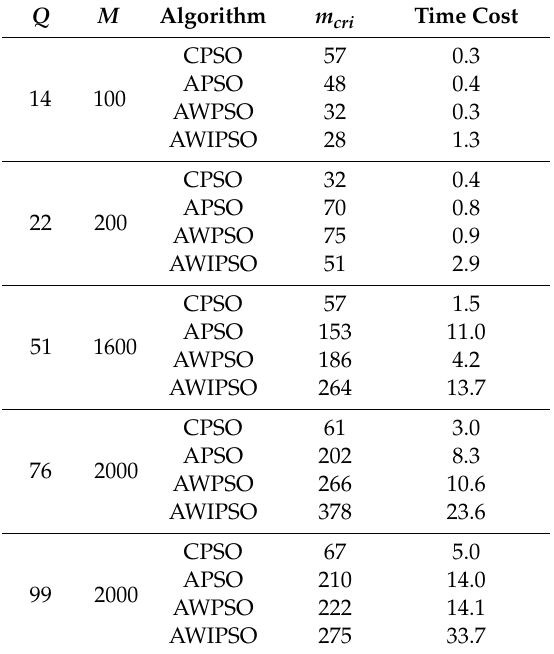
Table 4. Simulating results of computing e ffi ciency for each